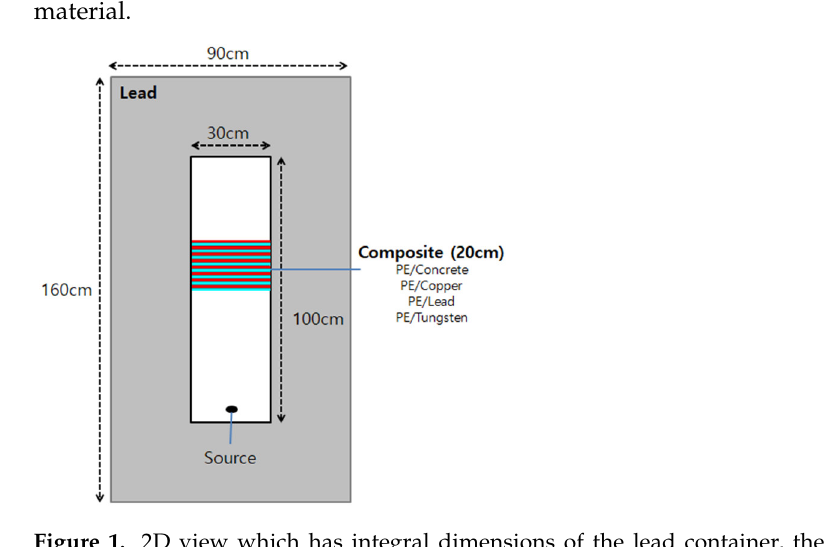
Figure 1. 2D view which has integral dimensions of the lead container, the cavity and source composite distance.